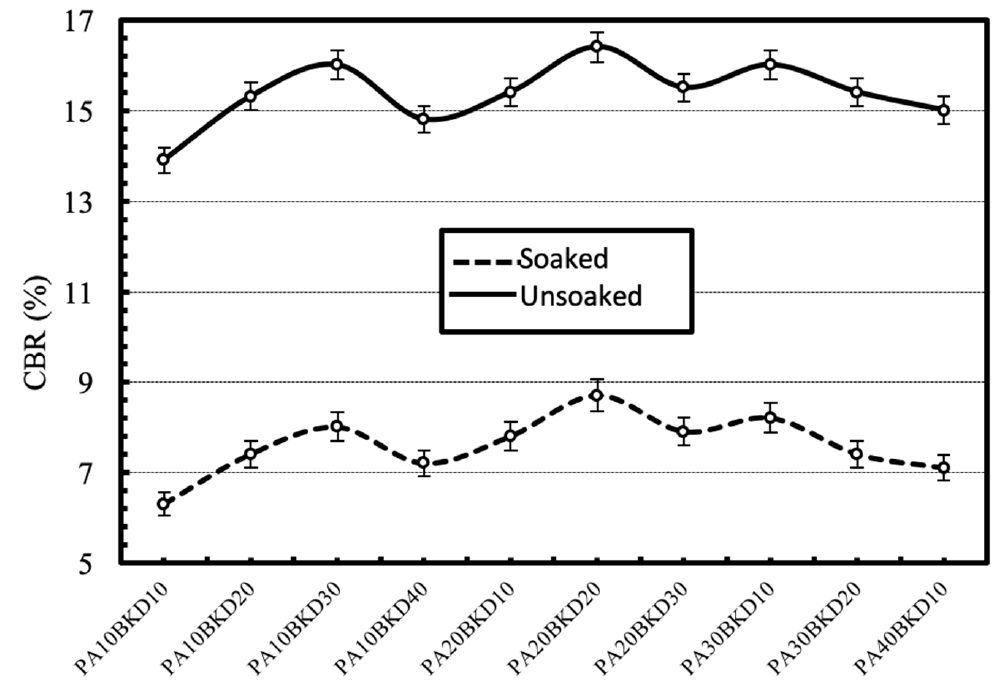
Figure 11. Variation in CBR of the geomaterial with varying combinations of pond ash and brick kiln dust under soaked and unsoaked conditions.